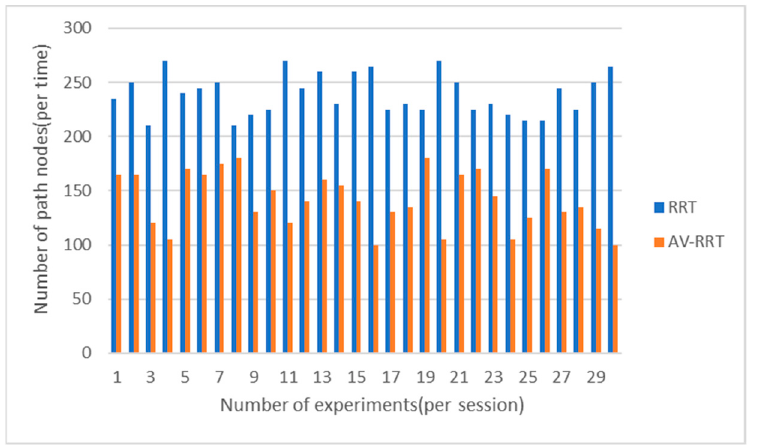
Figure 19. Comparison of the number of path nodes in the scene with moderate obstacles.